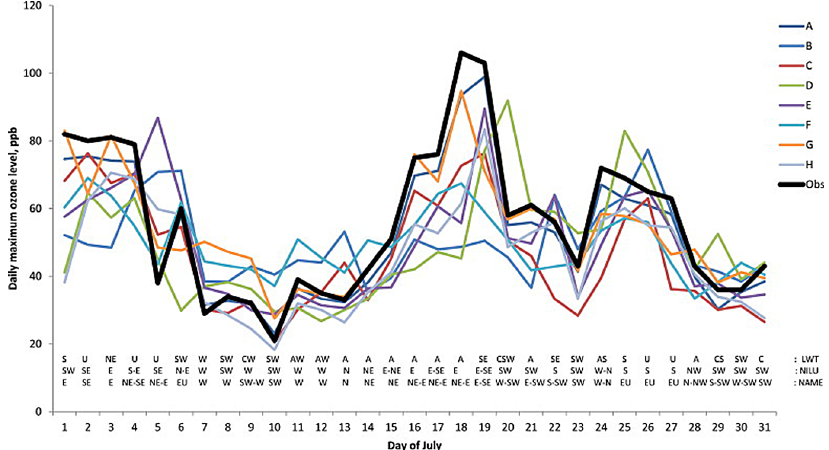
Figure 35. Daily maximum hourly ozone concentrations for eight models, A–H, in a comparison exercise against observations for July 2006 at Harwell, Oxfordshire, UK. Also shown are the daily advection regimes as Lamb weather types (LWT), NILU FLEXTRA trajectories (NILU) and NAME air history maps (NAME); see Derwent et al.